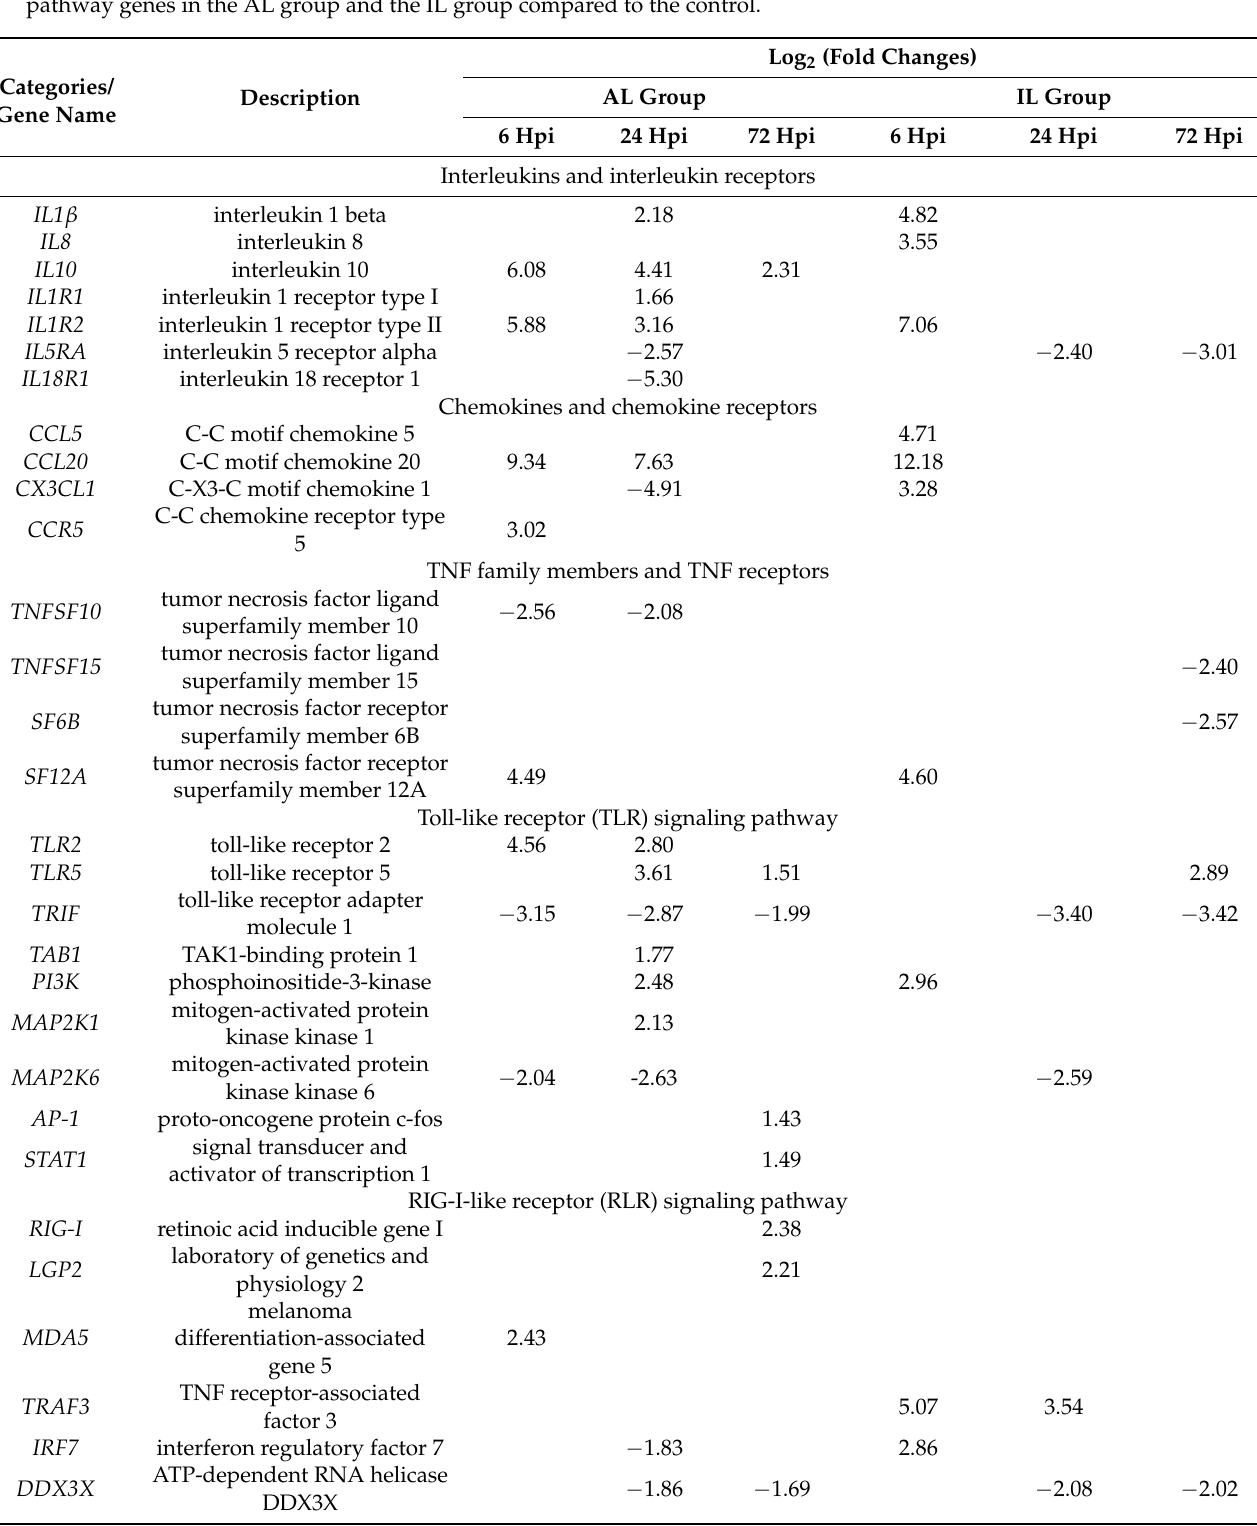
Table 1. Fold changes of differentially expressed cytokine and cytokine receptor, and cytokine expression mediating pathway genes in the AL group and the IL group compared to the